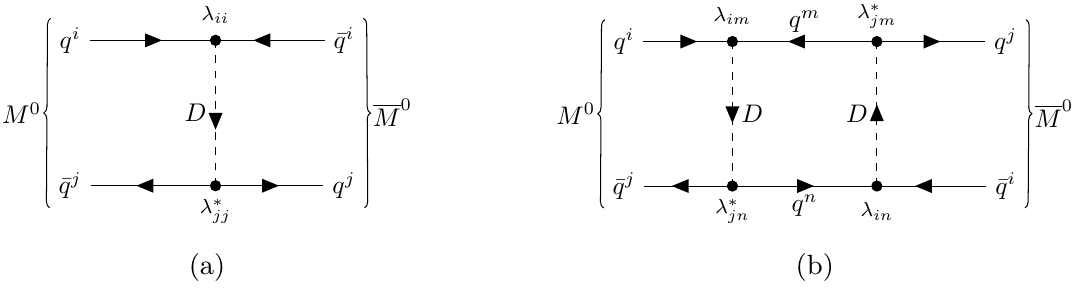
Figure 1 . Diquark contributions to M 0 - (cid:22) M 0 mixing at (a) tree level and (b) one